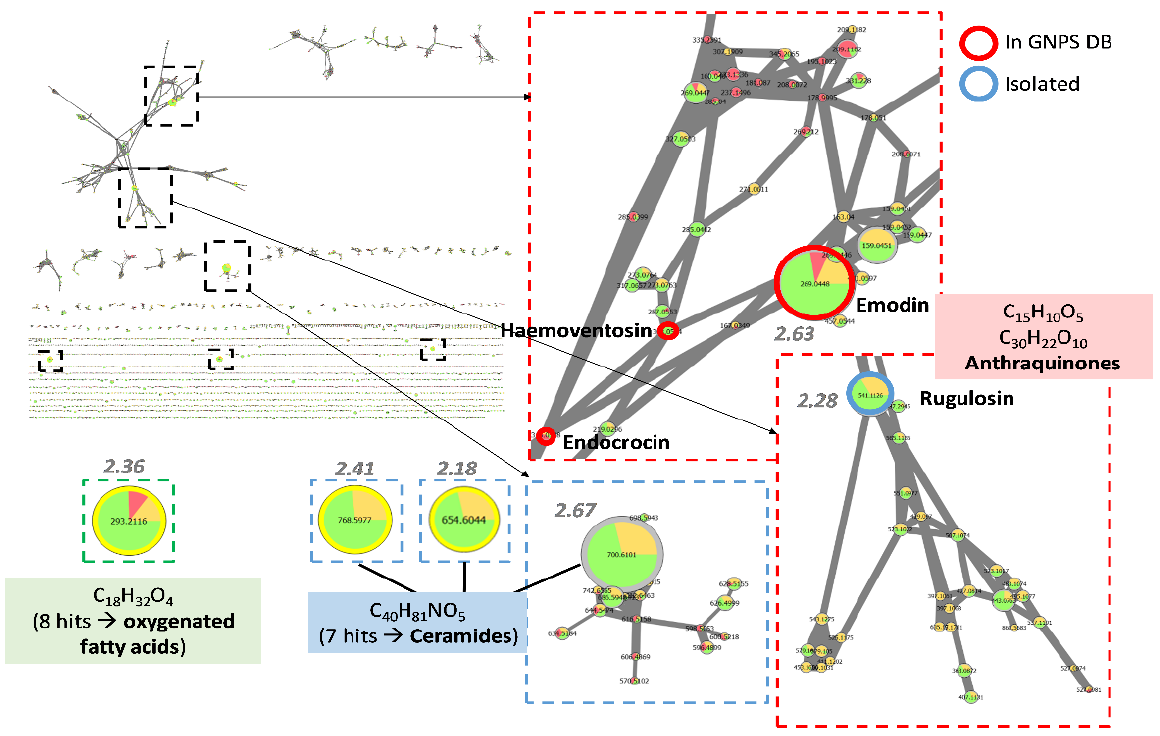
Figure 3. Feature-based molecular network corresponding to Coniochaeta extracts. Nodes are filled with pie charts representing the mean peak areas for each feature in the 3 defined groups of activity (anti-maturation activity at 100 µg/mL in 48 h): low (red) for 0–40%, medium (orange) for 40–60% and high (green) for 60–100%. Node sizes are related to FiBiCo scores indicated in grey, highlighting compounds mostly linked to the activity observed. Nodes with corresponding hits in the GNPS MS/MS spectra library (with cosine > 0.65) are surrounded by a red circle, nodes which correspond to compounds isolated in the present study by a blue